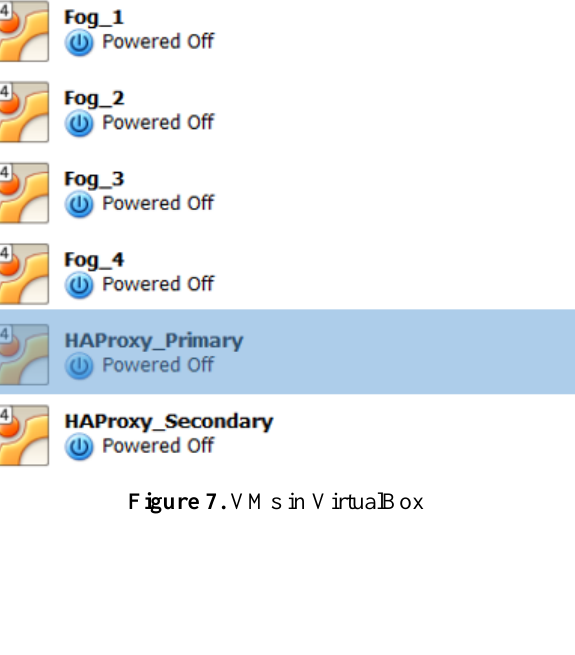
Figure 7. VMs in